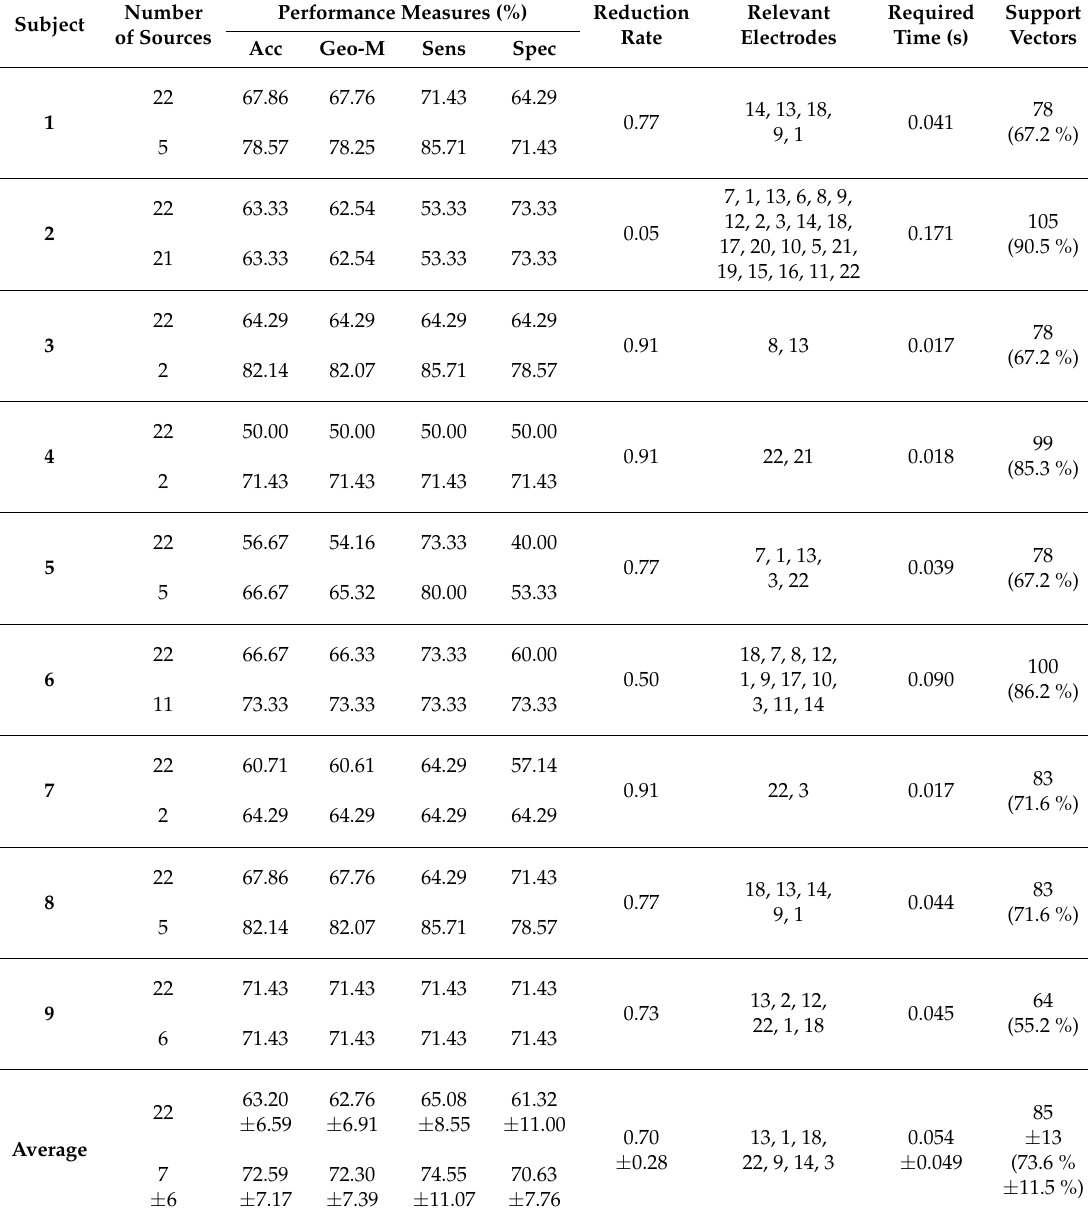
Table 3. Results of selection of BCI channels applying the Algorithm 3 and (cid:96) 2